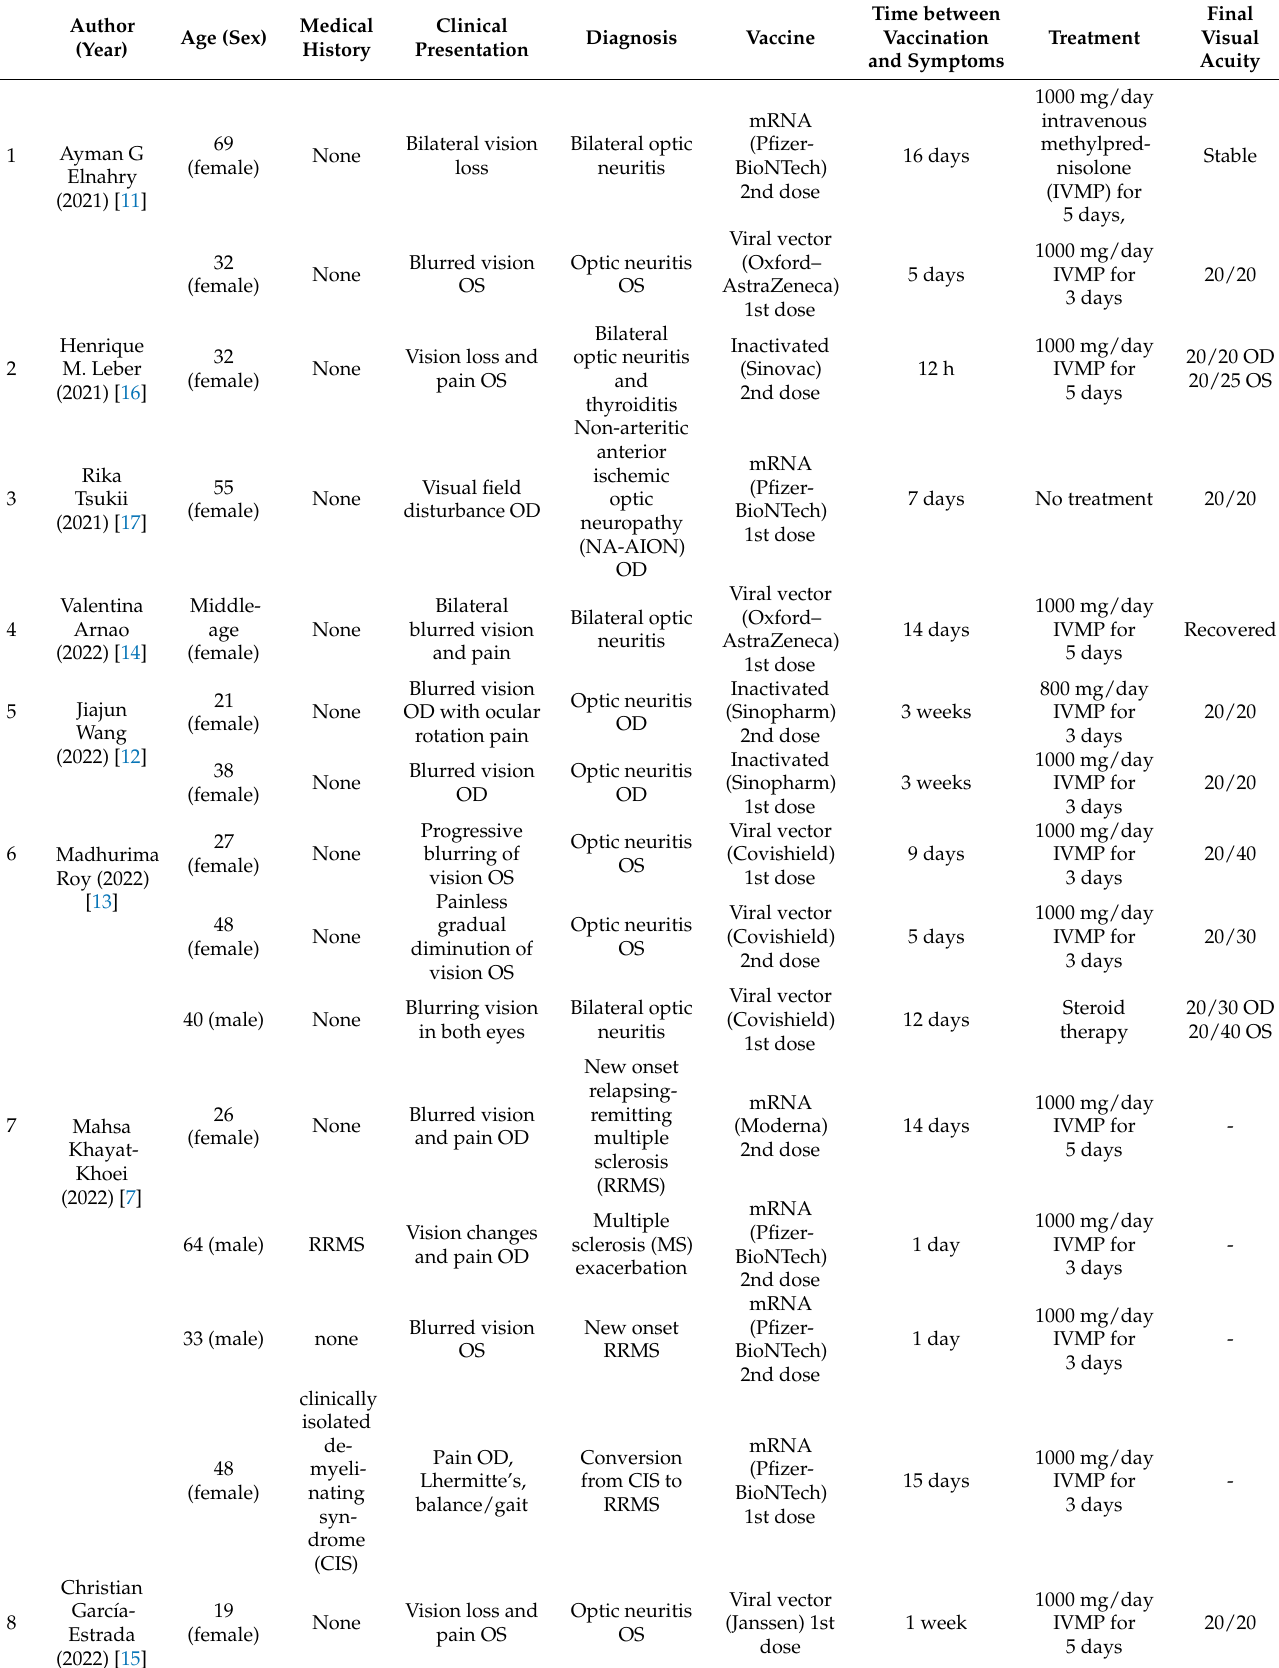
Table 1. Published cases reports of optic neuropathy after receiving COVID-19